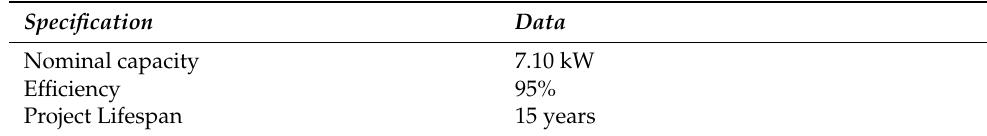
Table 5. Technical specification of the diesel generator